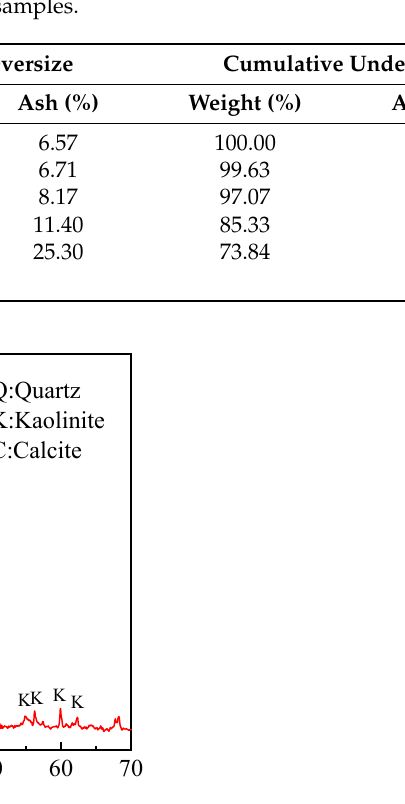
Table 1. Particle size distributions of the coal samples.